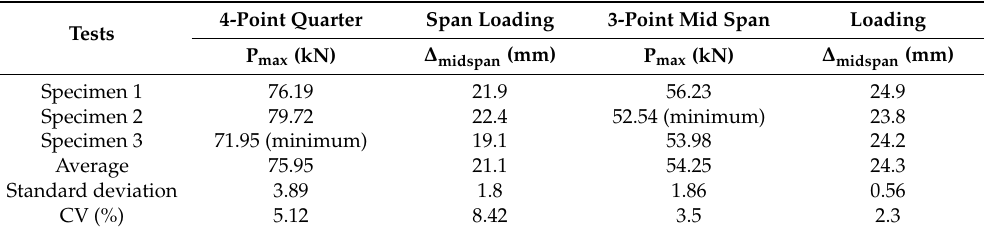
Figure 8. Four-point quarter-span loading flexural test results. Table 2. The least maximum applied forces and their related midspan deflections.